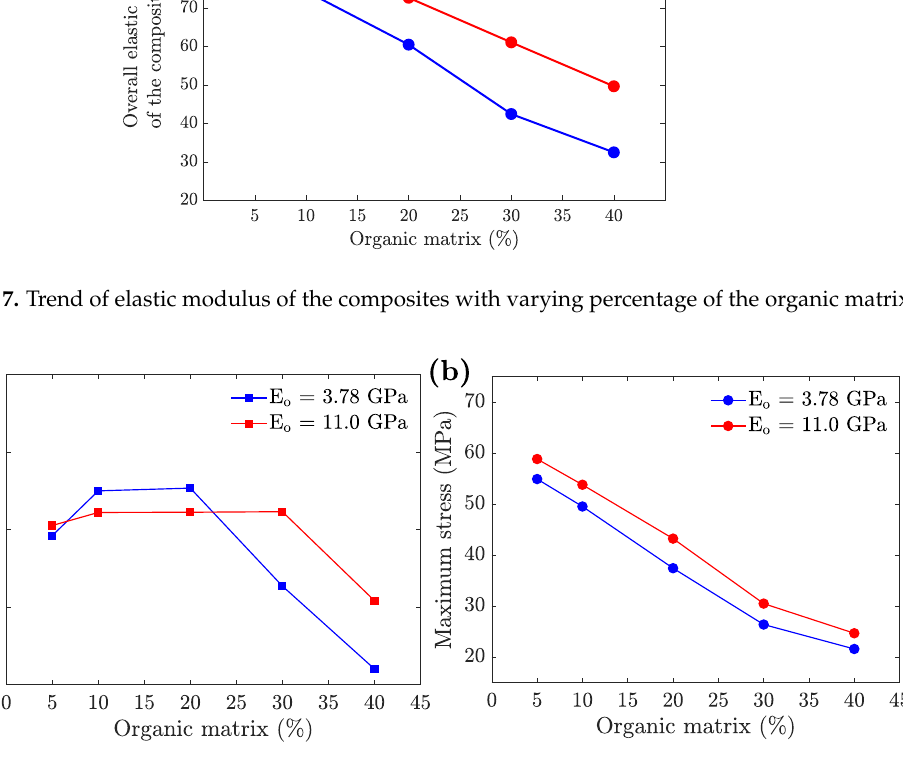
Figure 8. Trend of ( a ) toughness and ( b ) maximum stress with variation in percentage of the organic